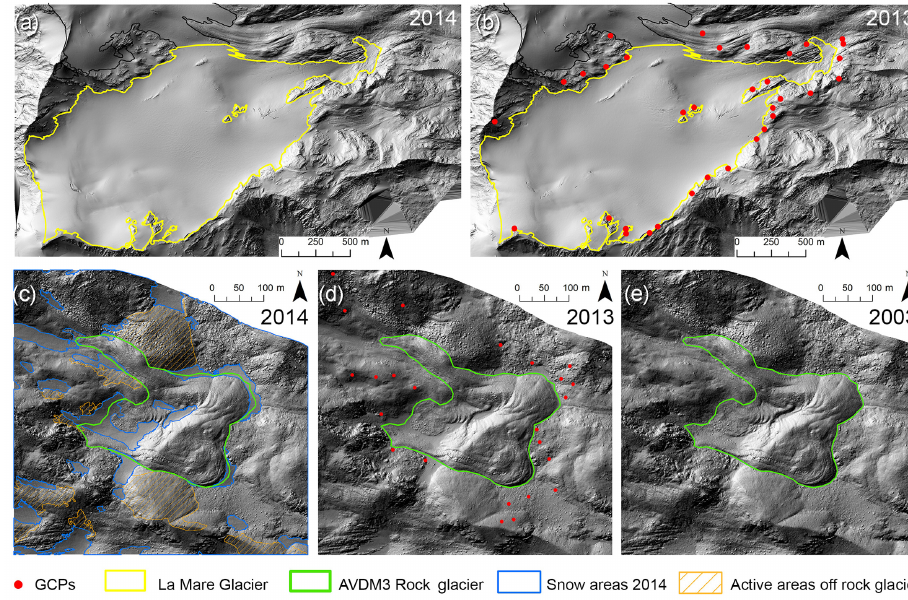
Figure 2. Hillshade of the ALS DEMs of La Mare Glacier acquired on (a) 24 September 2014 and (b) 21 September 2013. Hillshades of the ALS DEMs of rock glacier acquired in (c) 2014, (d) 2013 and (e) 2003.The red dots represent the selected ground control points (GCPs) in 2013 DEM used for the photogrammetric approach. The snow accumulation areas and the geomorphologically active areas outside the rock glacier were excluded during the ICP computation between 2013 and 2003, 2014 ALS point